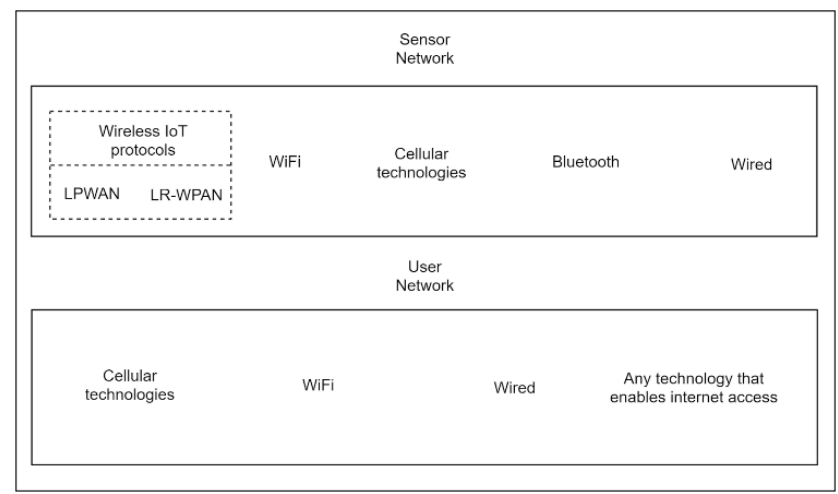
Figure 3. Network design